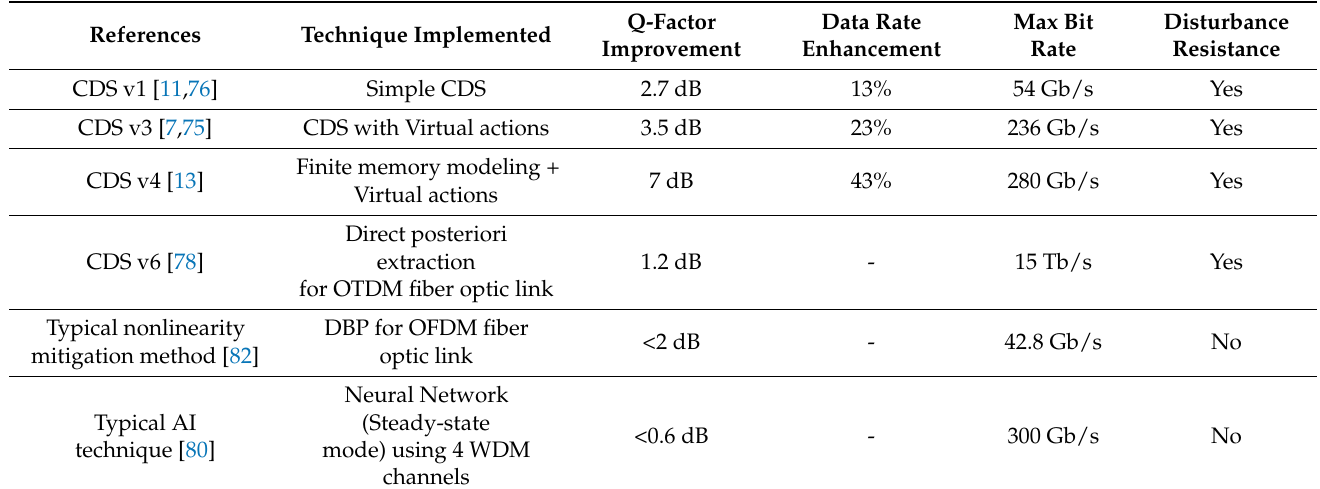
Table 3. Comparison of the typical AI and DBP methods and the CDS versions 1, 3, 4, and 6.